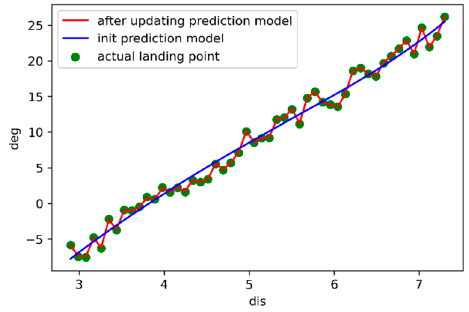
Figure 8. Curve of simulation experiment results.